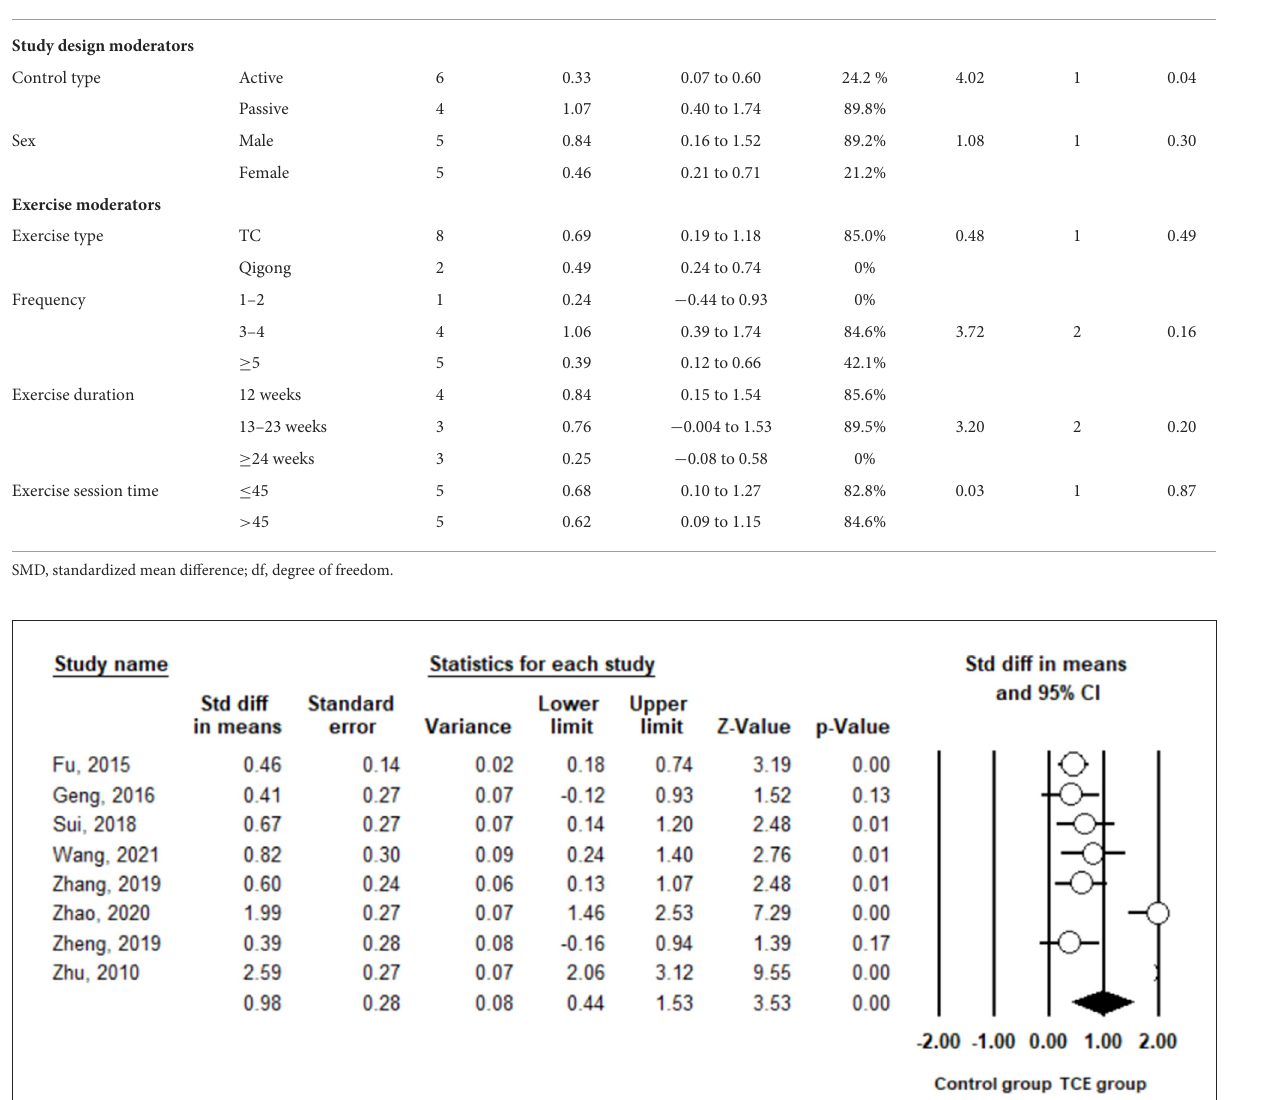
FIGURE5 The effect of Traditional Chinese exercises on the anxiety.